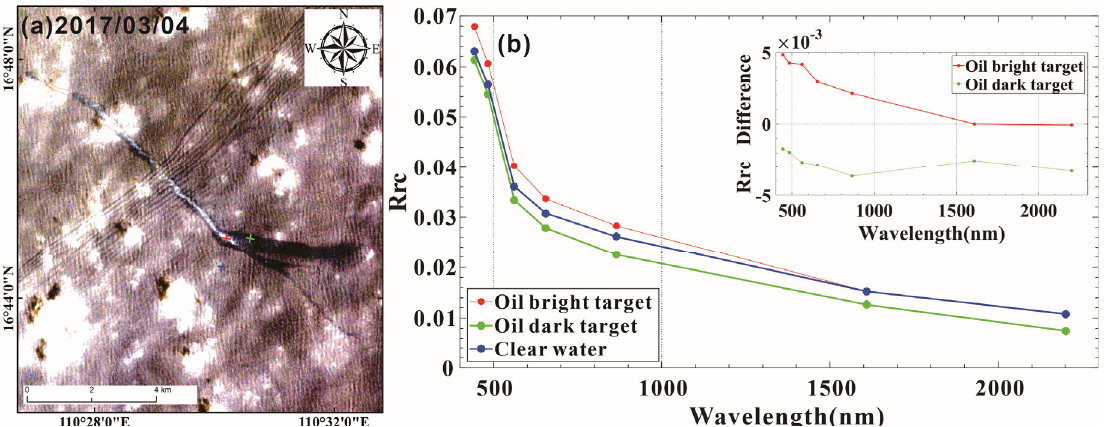
Figure 3. ( a ) Outlined oil slicks in the NSCS: ( b ) Rrc reflectance spectra from the marked points in panel a. The inset shows the Rrc difference (oil–water) between oil and clear water.